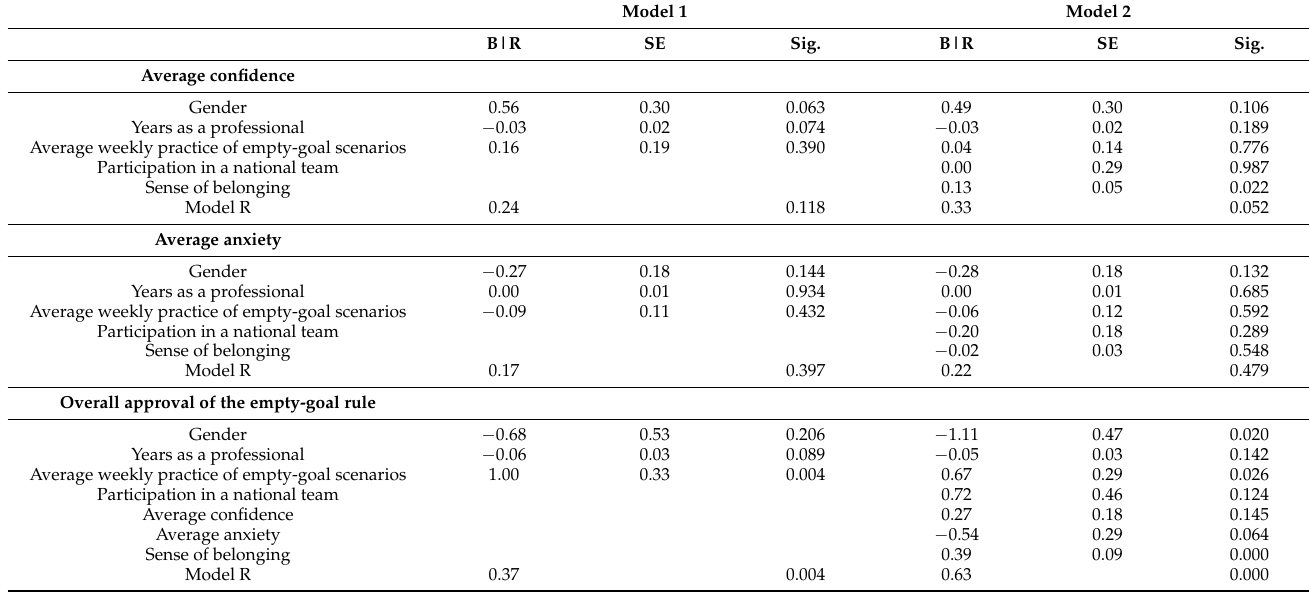
Table 6. Multiple linear regression unstandardized